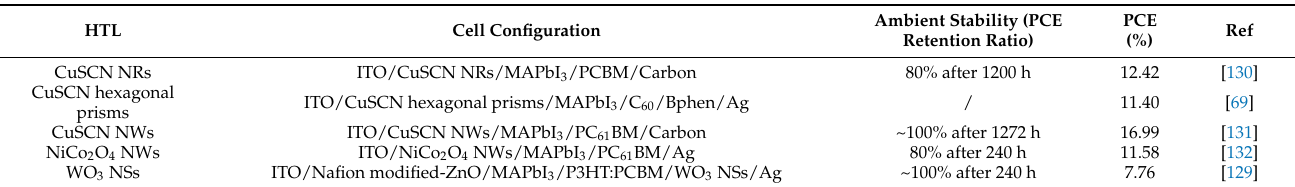
Table 2. Performance comparison of PSCs based on nanostructured inorganic HTLs with differ- ent